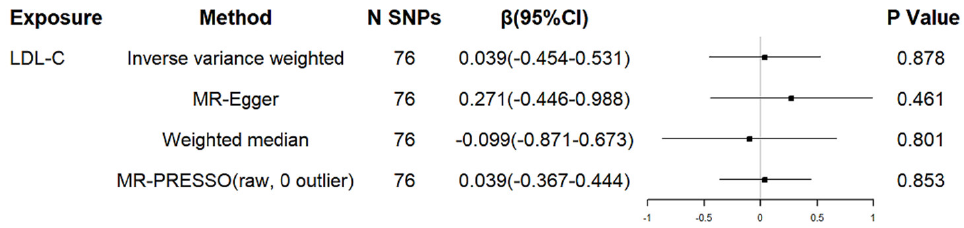
Figure 1. MR associations between genetically determined LDL cholesterol and residual age at onset of HD. LDL-C: low-density lipoprotein cholesterol; SNP: single nucleotide polymorphism; CI: confidence interval; HD: Huntington’s disease.